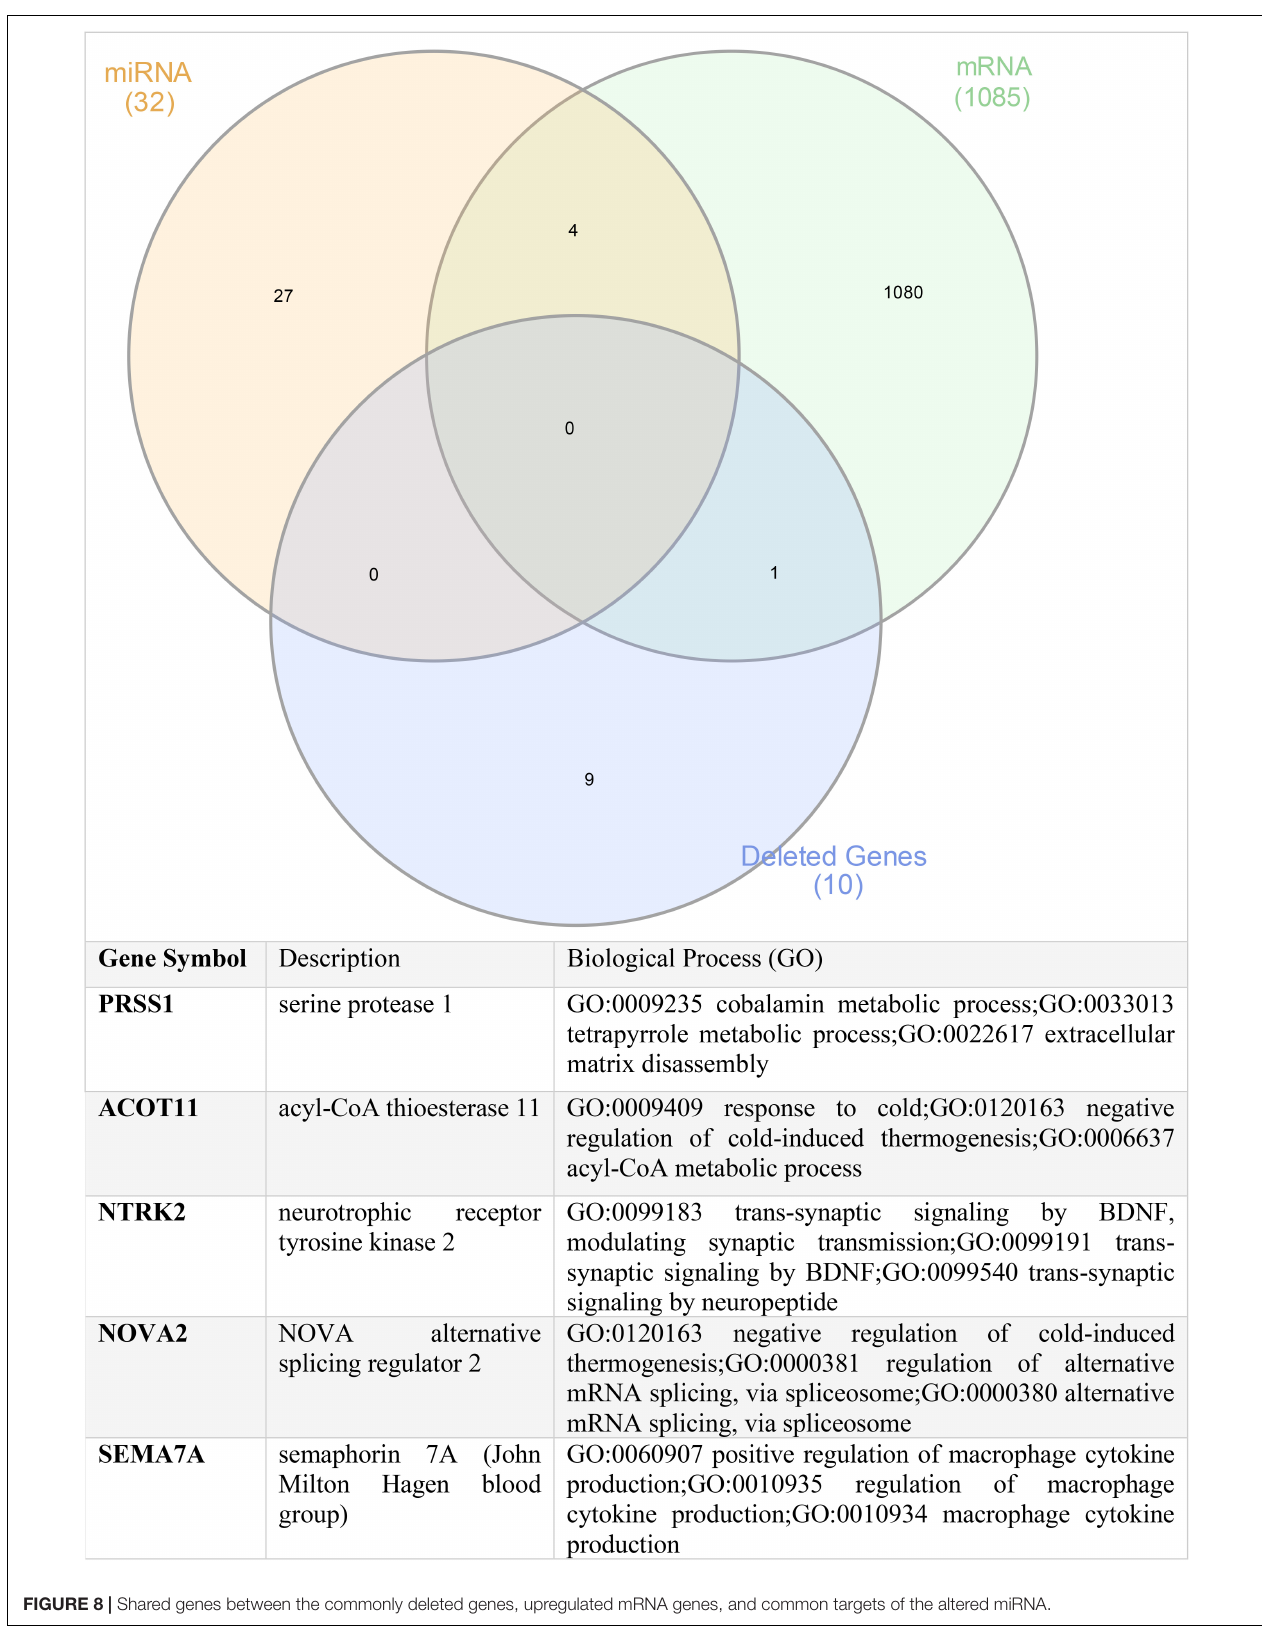
Frontiers in Cell and Developmental Biology |